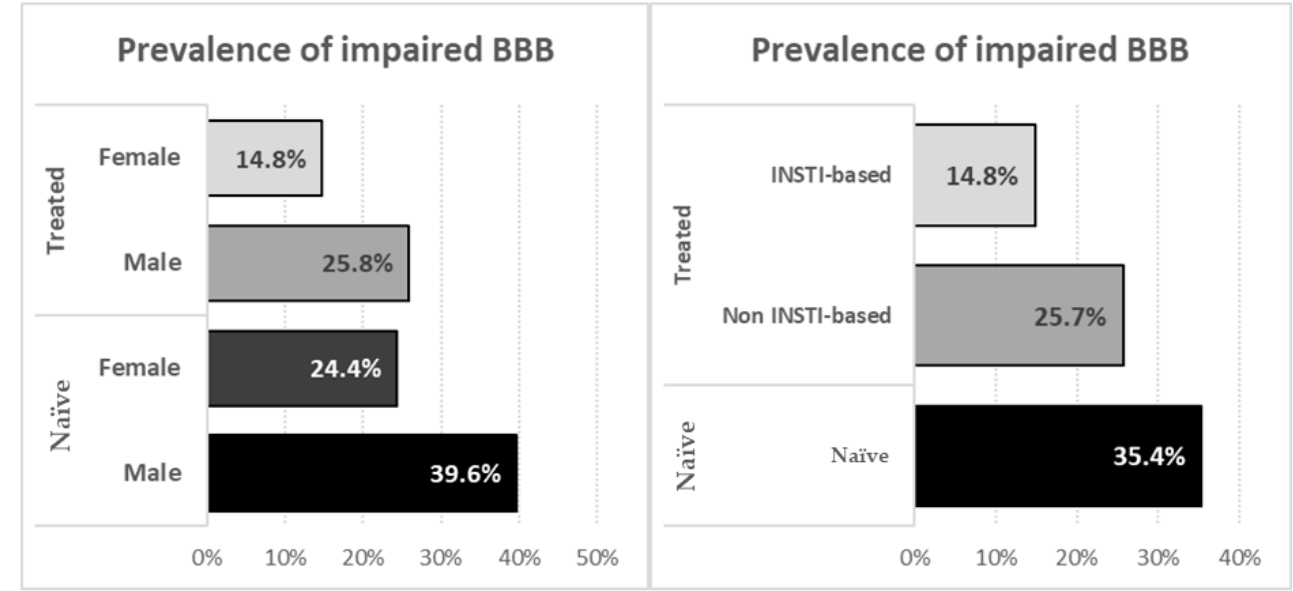
Figure 1. Prevalence of impaired blood–brain barrier stratified according to sex ( left panel) and to treatments ( right panel).